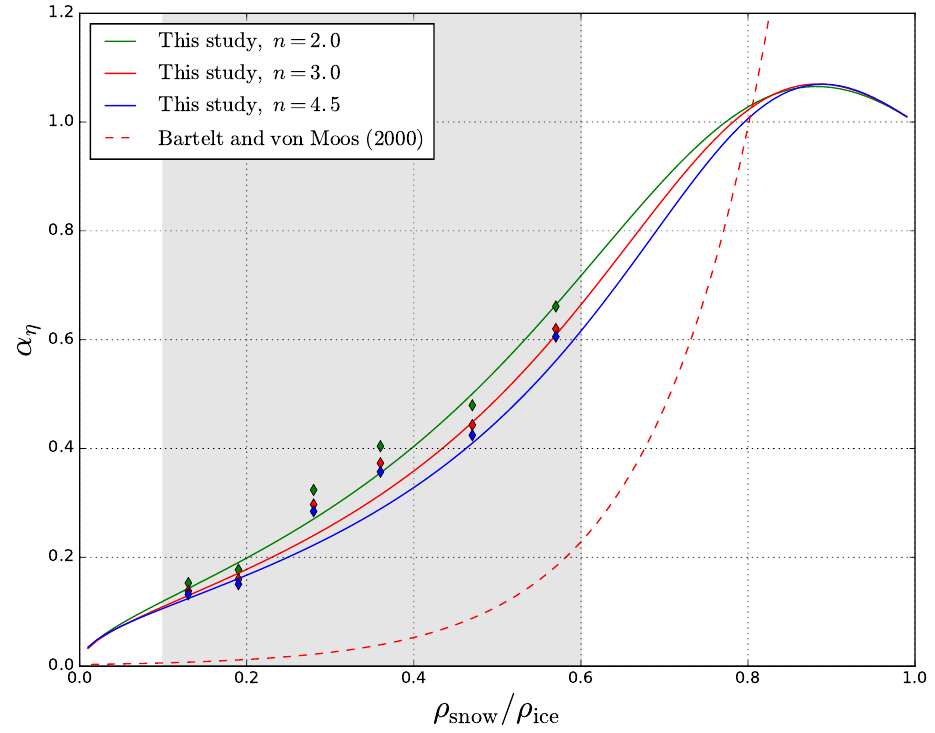
Figure 13. Comparison between our theoretical prediction for α η (Eq. 47) and the experimental fit proposed by Bartelt and von Moos (2000). The points computed directly from the values for f and c reported in Table 3 are shown as diamond points. The relative density range for snow samples under consideration is materialized by the gray